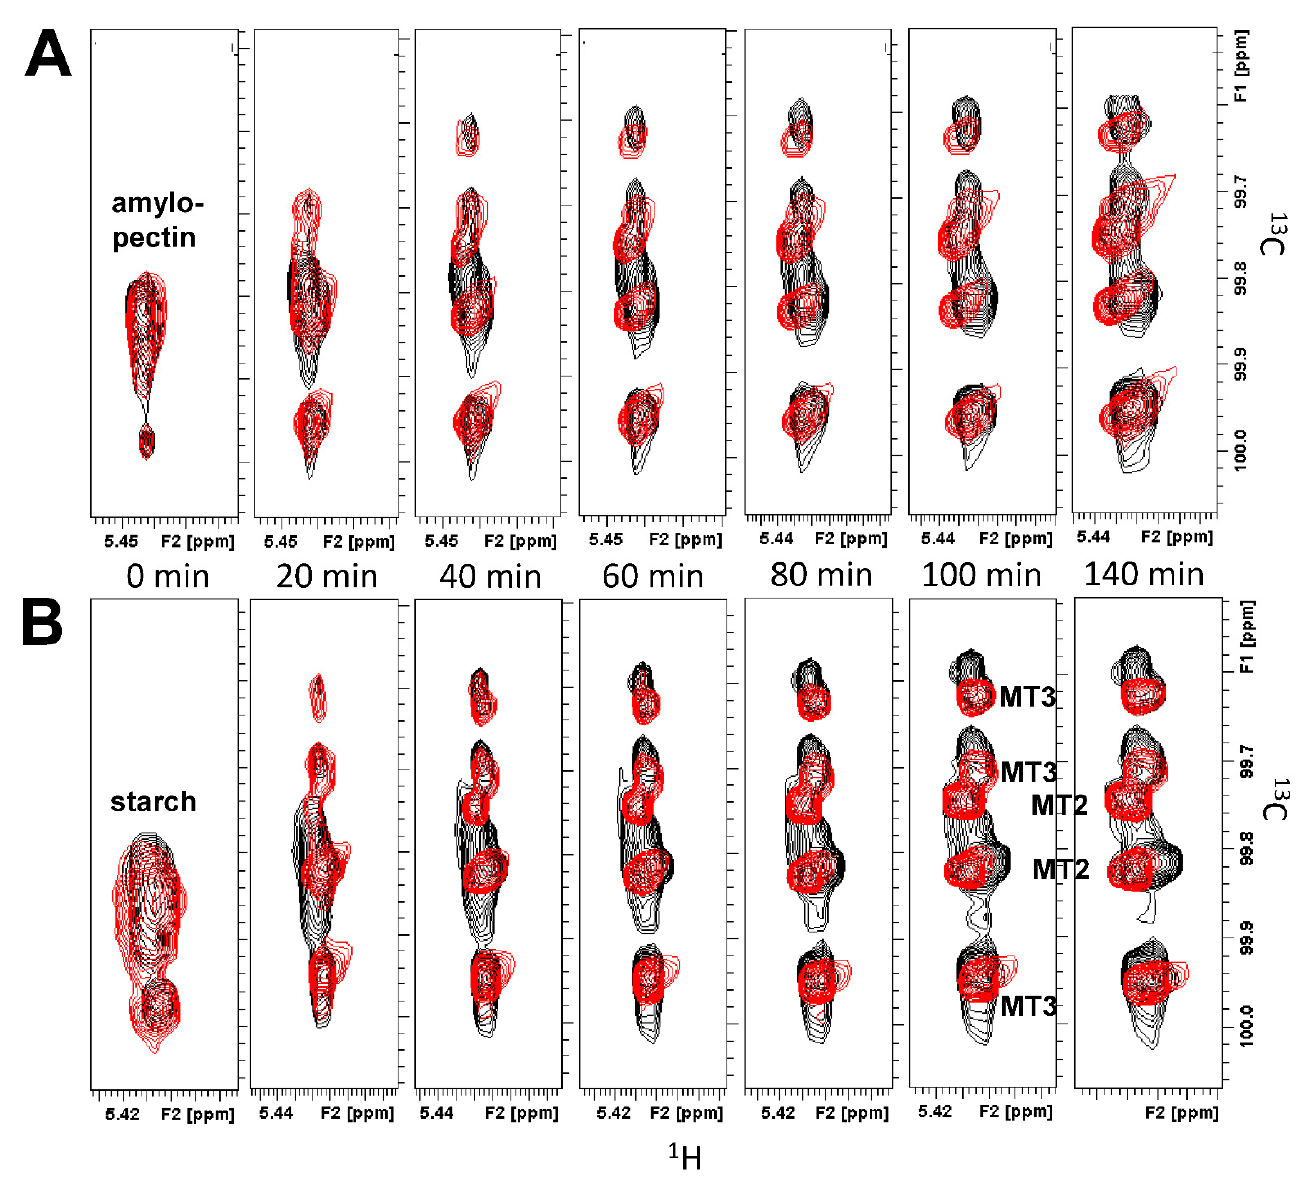
Figure 3. Natural abundance 13 C HSQC showing time dependence of α‐ amylase ‐ mediated (0.4 U/mL) hydrolysis of amylopectin ( A ) and starch ( B ). These kinetics runs focused on resonances from acetal groups and acquired 13 C HSQC spectra over a narrow spectral window in the 13 C dimension, as discussed in the text and legend to Figure 2. HSQC spectra are shown in the absence (black contours) and presence (red contours) of GM α (4.2 mg/mL). Time points are indicated on the figure. Solution conditions are 20 mM potassium phosphate, pH 7, 30 °C.